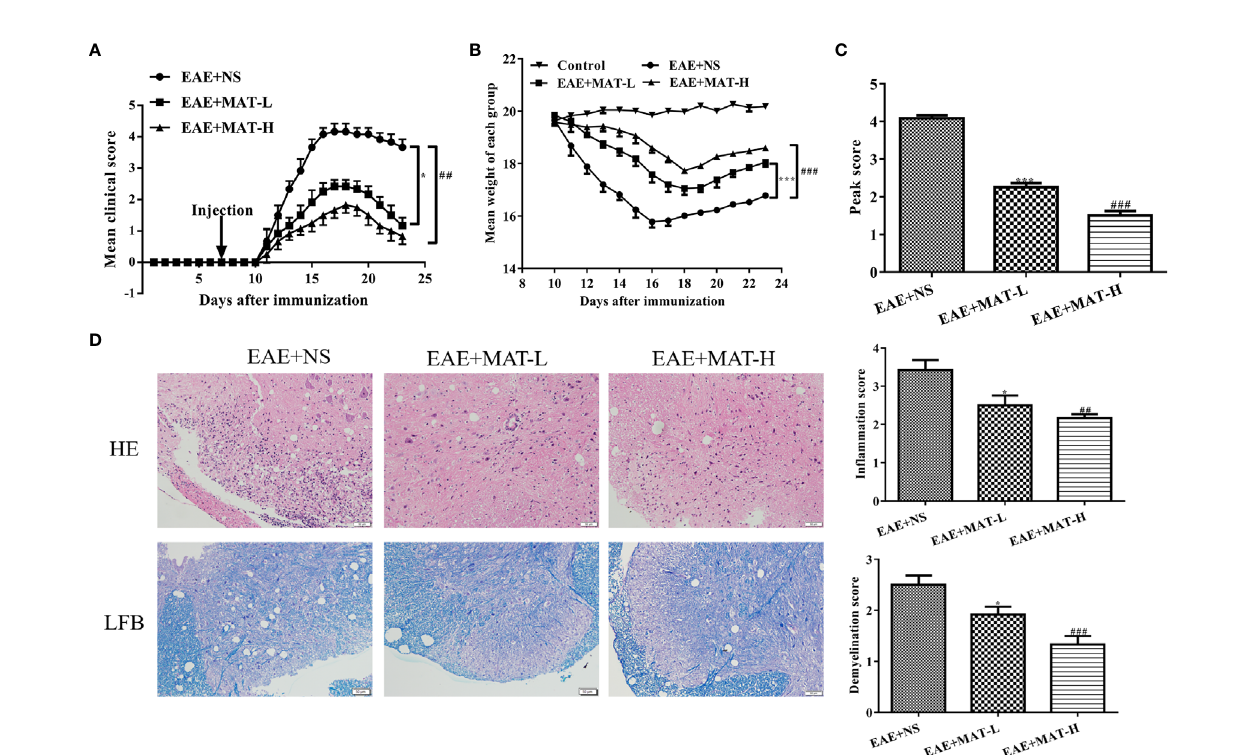
FIGURE 6 | Matrine treatment reduced EAE severity, CNS in fl ammatory in fi ltration and demyelination. EAE was induced in C57BL/6 mice by MOG35-55/CFA/PTX as described in Materials and Methods. Starting from day 7 p.i., 0.1 ml MAT at 100 mg/kg (MAT-L) or 200 mg/kg (MAT-H) was i.p. injected daily, and the control mice were given the same volume of normal saline (NS). Mean clinical score (A) , body weight (B) and peak score (C) of EAE+NS, EAE+MAT-H, EAE+MAT-L and naïve control group. The lumbar enlargement of the spinal cord was harvested on day 23 p.i. after heart perfusion. H&E staining was used to evaluate the levels of in fl ammatory in fi ltration, and LFB staining to evaluate the levels of demyelination. (D) H&E and LFB staining of the spinal cord in all groups. * or *** represents the comparison between EAE+NS and EAE+MAT-L groups, and ## or ### represents the comparison between EAE+NS and EAE+MAT-H groups. Data are shown as mean ± SD (n=10 each group). * P < 0.05; ## P < 0.01; *** or ### P <